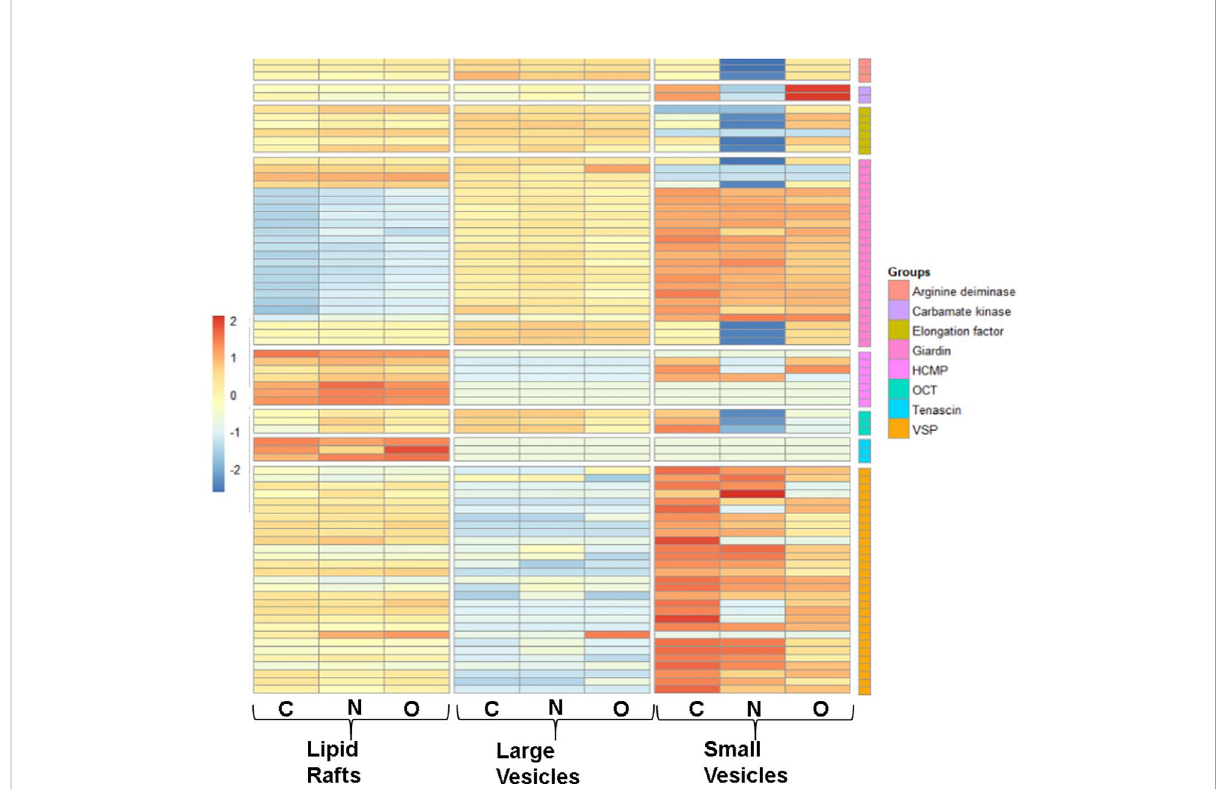
FIGURE 9 Differentially expressed heatmap patterns of potential giardial virulence factors such as arginine deiminase (AD), carbamate kinase (CK), elongation factor (EF), giardin, high cysteine membrane protein (HCMP), ornithine carbamoyltransferase (OCT), tenascin, and variant surface protein (VSP). Each heatmap contains proteins between control (C) and treatments with nystatin (N) (27 m M) and oseltamivir (O) (20 m M) within isolated lipid rafts, large vesicles and small vesicles. Protein samples included have a p-value ≤ .05 between normalized data in scaffold and have been transformed to a Z-score for visual simpli fi